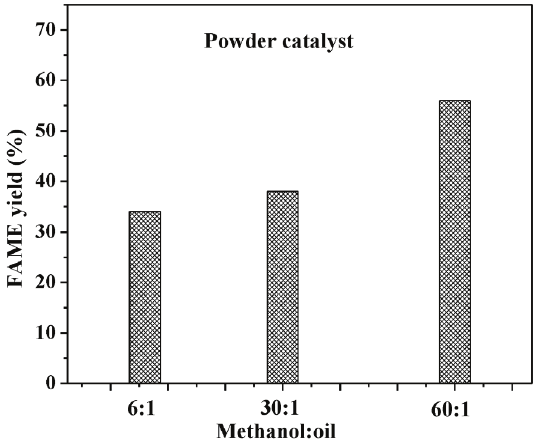
Fig. 8 – FAME yield at different methanol to oil ratios for powdered Amberlyst15. Reaction conditions: catalyst amount = 18 wt% of oil; temperature = 393 K; rpm = 750; time = 8 h; reaction mixture volume = 341 mL.